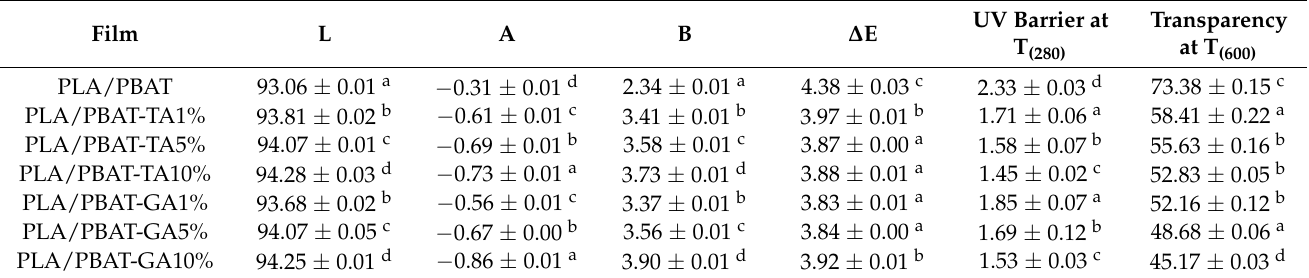
Table 1. Surface colour, UV barrier, and transparency of composite films incorporated with tannic acid and gallic